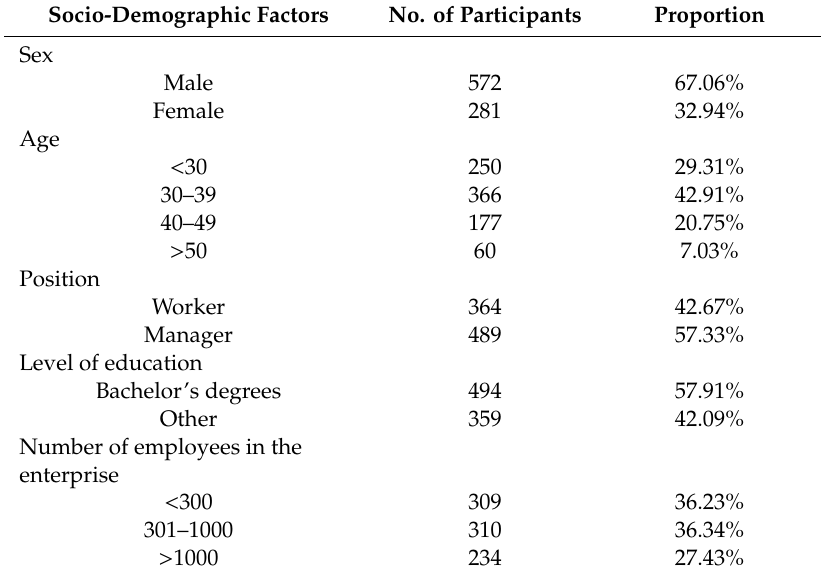
Table 2. Descriptive statistics ( N =